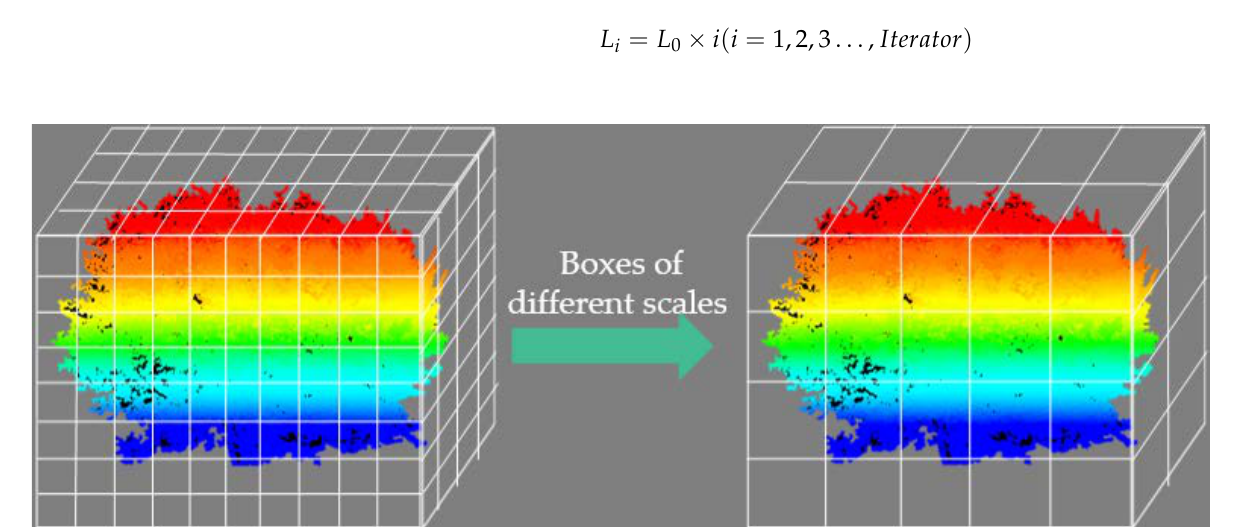
Figure 3. The principle of using box-counting dimension method to calculate fractal dimensions of point clouds. After specifying the way and step of box-dividing, the main process of calculating the fractal dimension of terrestrial point clouds is shown in the Figure 4.